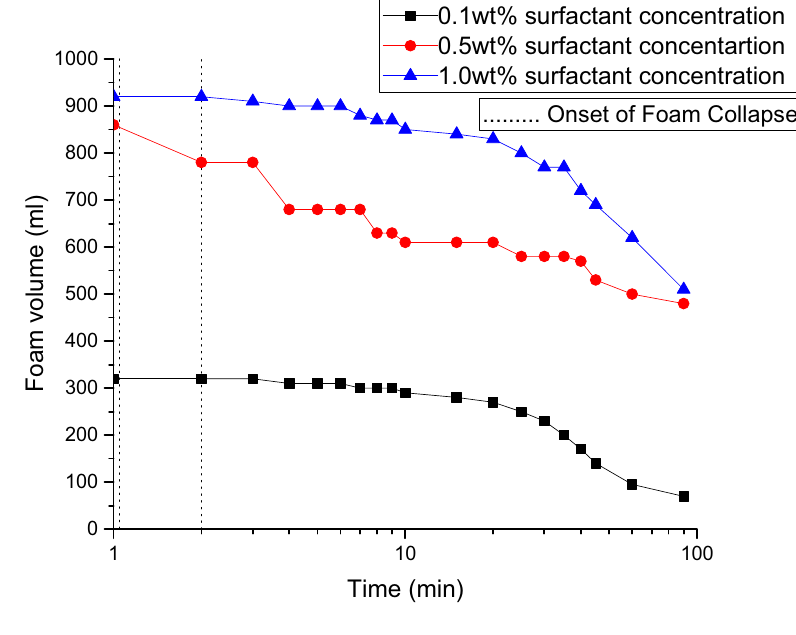
Fig. 8 Determination of the effect of surfactant concentra- tion by modified bulk foam stability